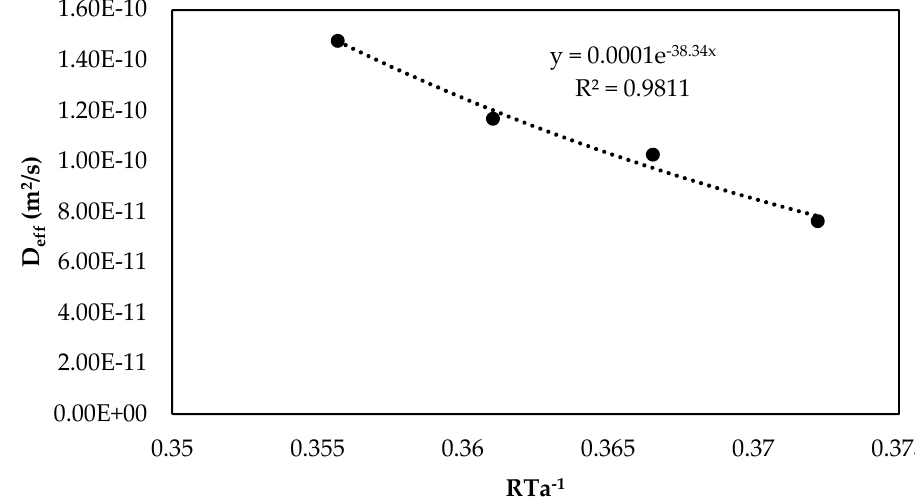
Figure 6. The relationship between change of D eff and RT a − 1 .